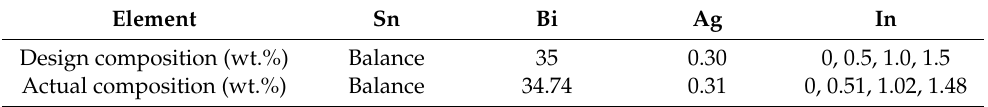
Table 1. Elements comparison table.